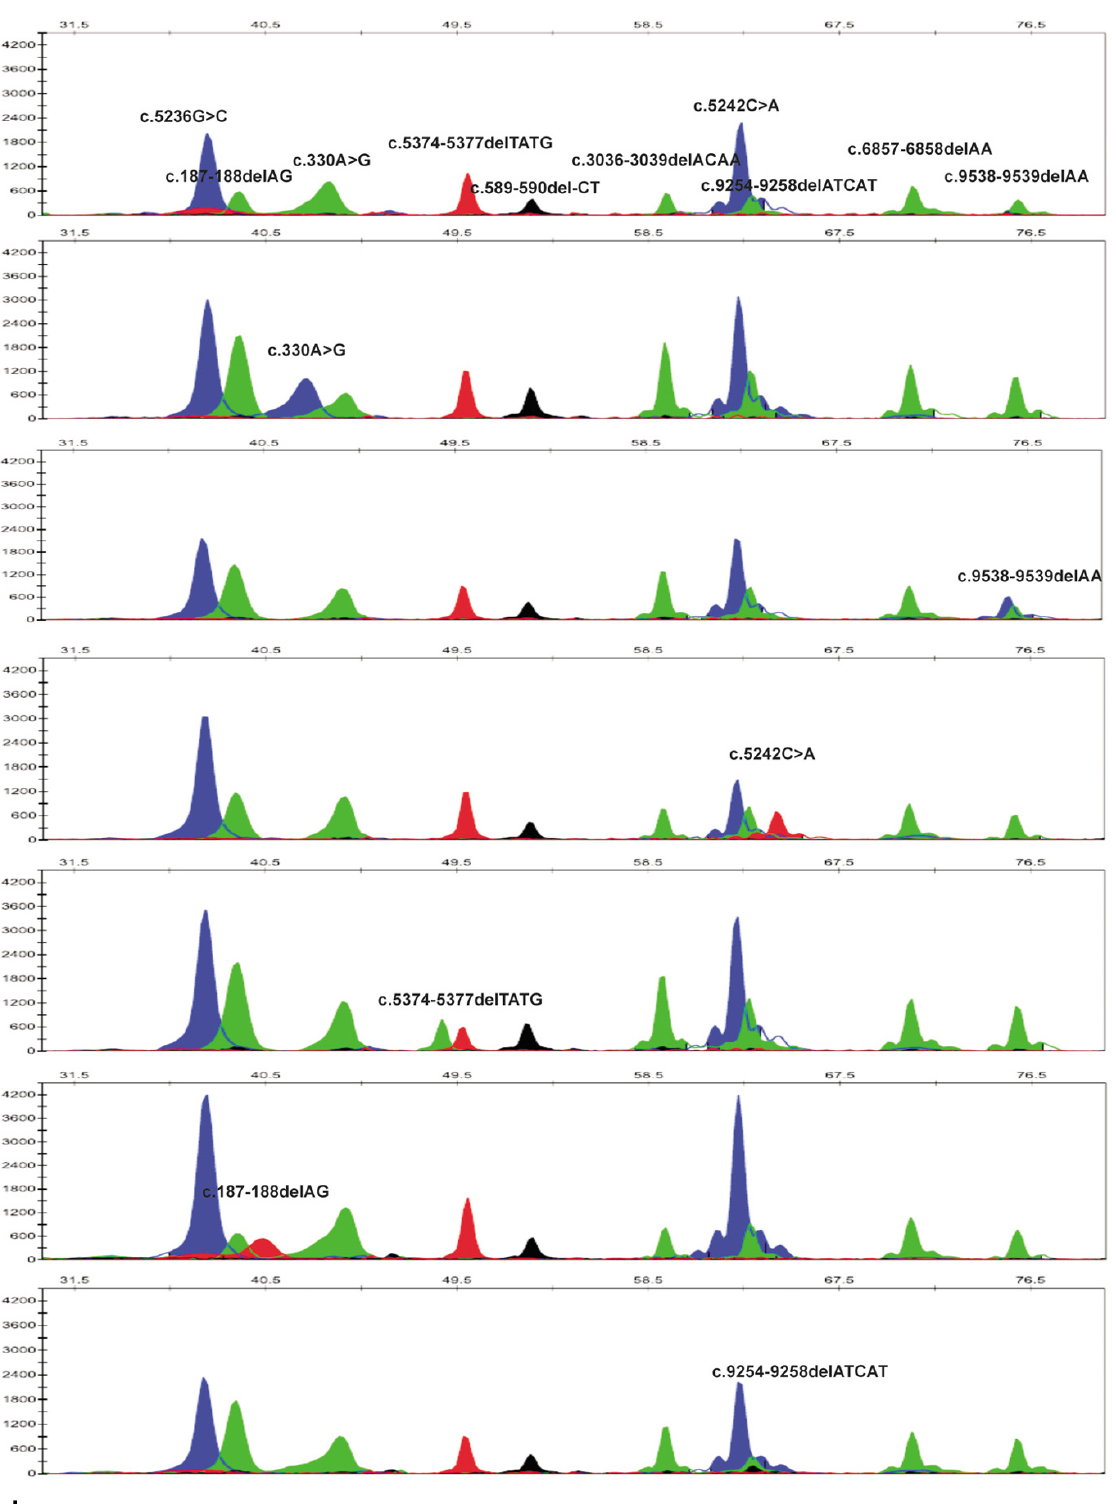
Figure 1 Electropherograms of Genscan Analysis of the SNaPshot reaction. On the top, a control DNA sample with the position and nucleotide of the wild type allele indicated. Following, electropherograms for the most frequents BRCA1/2